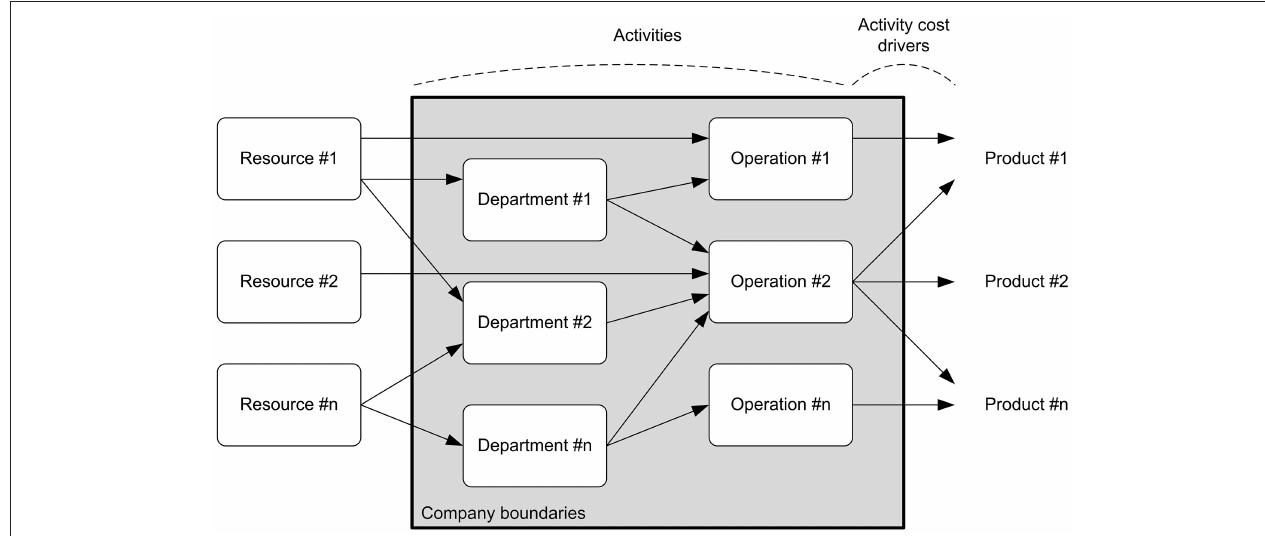
FIGURE 1 | Allocating company’s overheads under the ABC